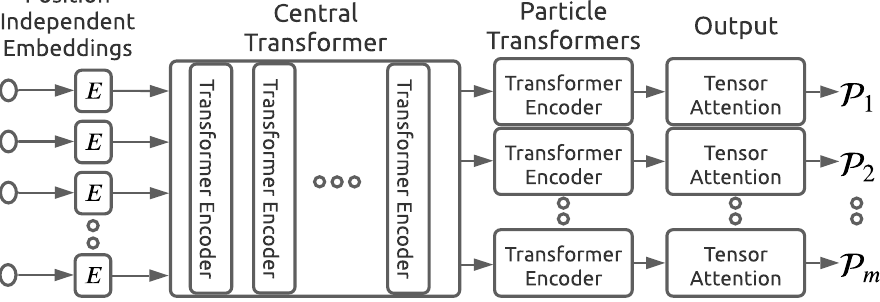
Figure 2: A visualization of the high level structure of S PA -N ET